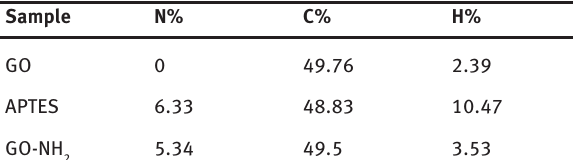
under various pH conditions; (B) Dependence of the GO-NH 2 =100 mg L −1 ; adsorbent dose=20 mg; temperature: 25 0 . 2